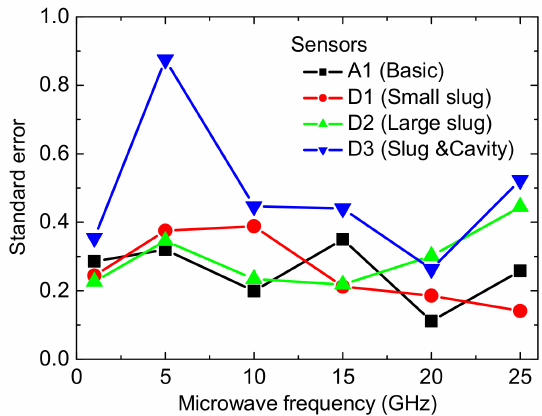
Figure 10. Standard error of the corresponding sensitivity in Figure 9. Table 1. Comparison of the MEMS thermoelectric power sensors in the GaAs process.